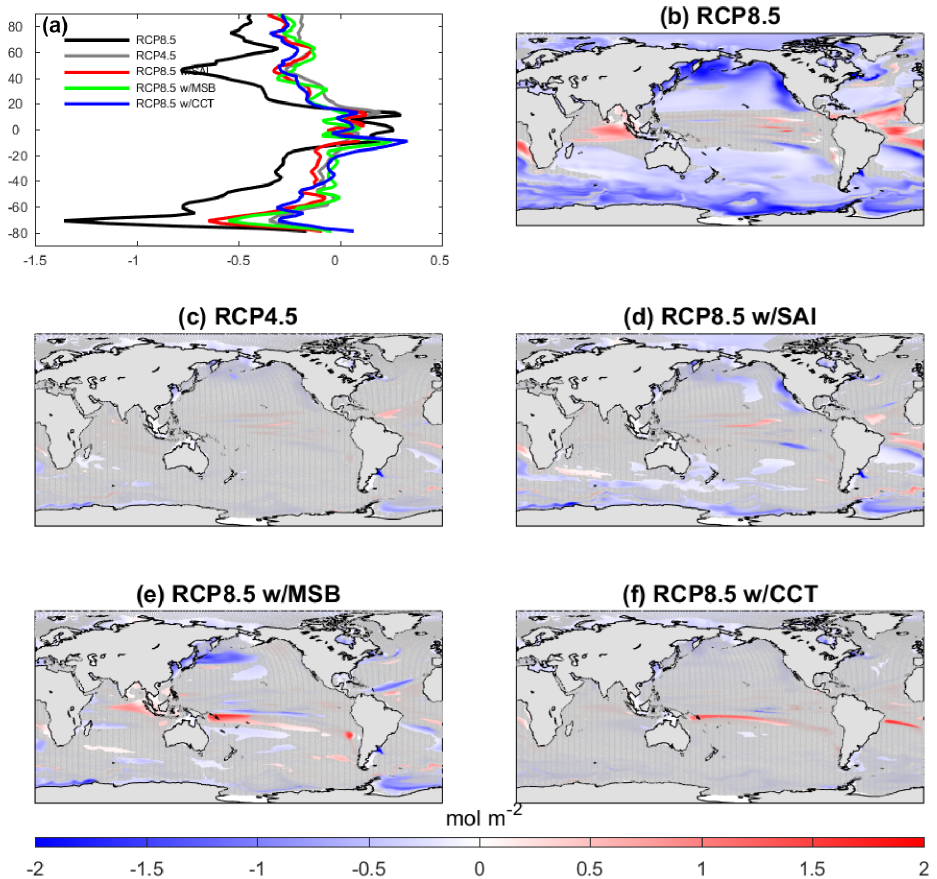
Figure 2. The absolute change in oxygen concentration (200–600m) in 2071–2100 relative to 1971–2000 (in molesO 2 m − 2 ) . Panel (a) shows zonally averaged (in 2 ◦ latitude bands) change for all simulations. Global maps of (b) RCP8.5, (c) RCP4.5, (d) RCP8.5 with SAI, (e) RCP8.5 with MSB, and (f) RCP8.5 with CCT. Gray shading in panels (b–f) indicates areas where the change is not significantly different from the 1971–2000 average (i.e., within 1 standard deviation of the 1971–2000